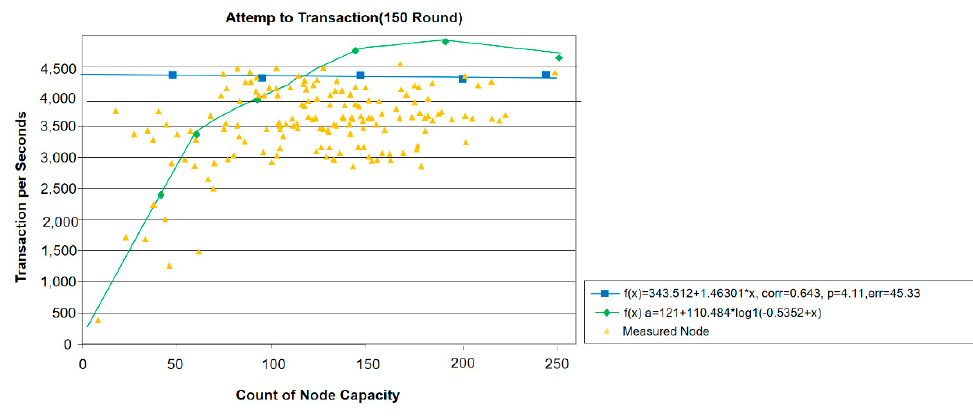
Figure 11. Blockchain performance data (unit, TPS).